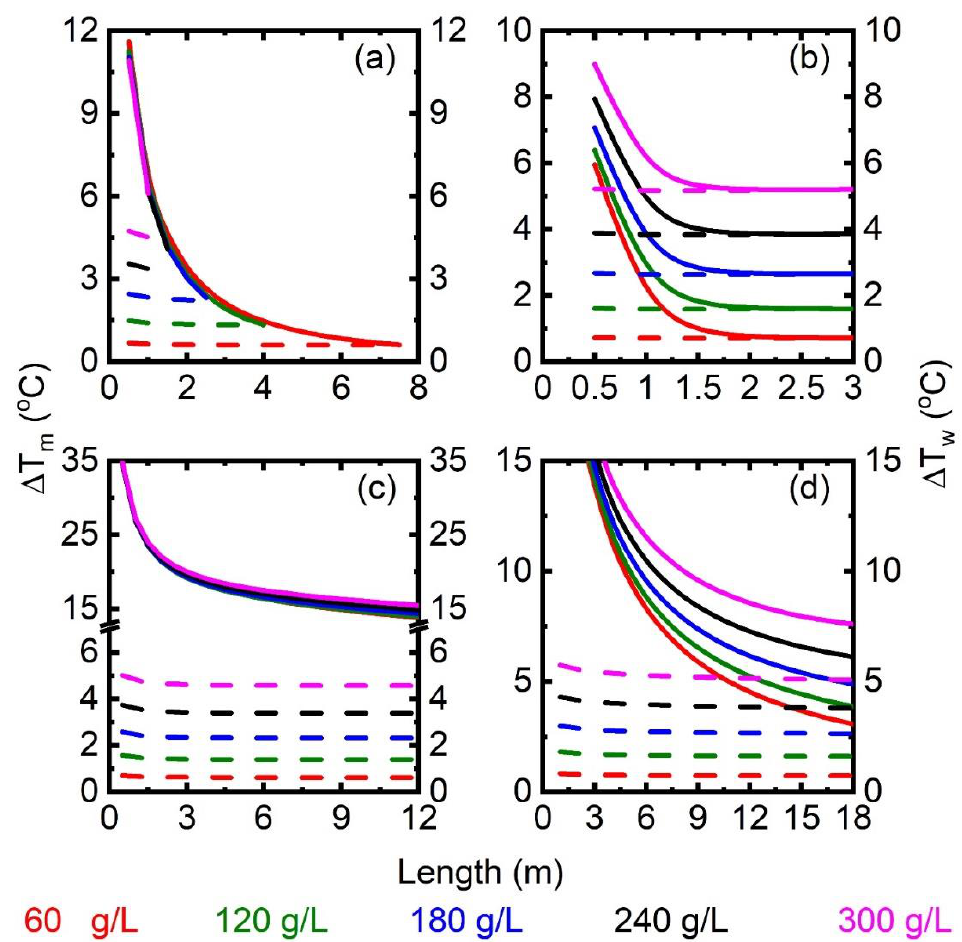
Figure 4. Variation in ∆ T m (solid lines—left y-axis) and ∆ T w (dashed lines—right y-axis) along the length at different feed salinities for ( a ) DCMD, ( b ) VMD, ( c ) SGMD, and ( d ) AGMD.